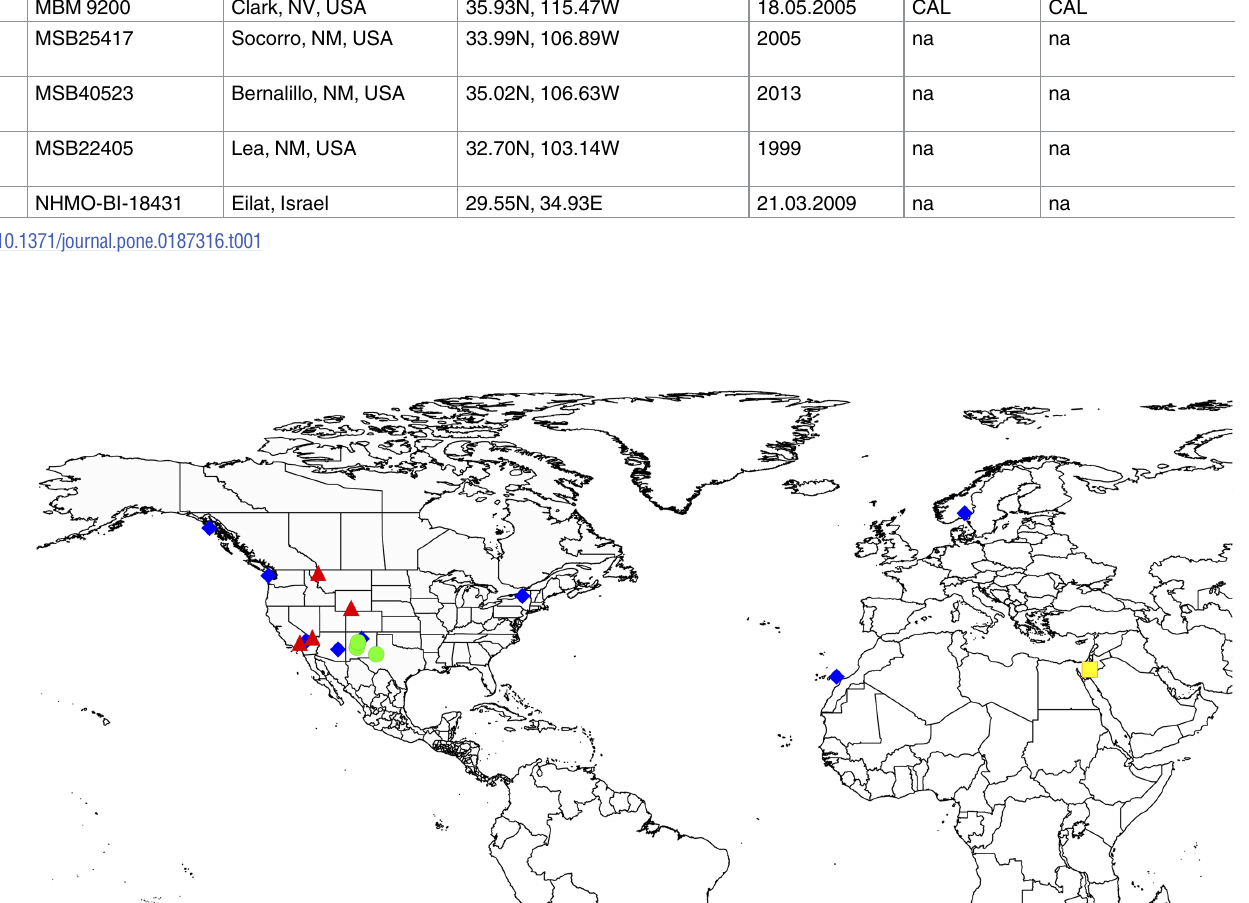
PLOS ONE | https://doi.org/10.1371/journal.pone.0187316 October 30,